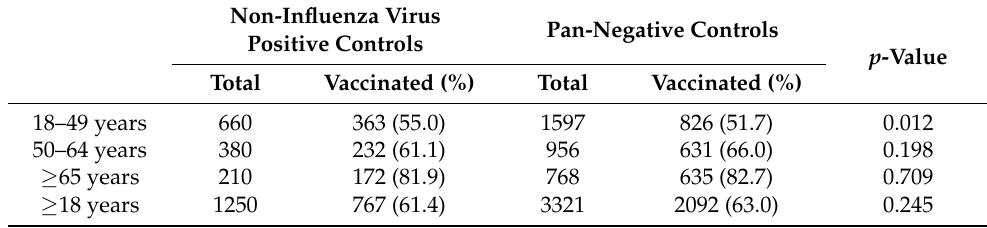
Table 4. Influenza vaccine coverage among patients tested non-influenza virus positive and patients tested pan-negative. Non-Influenza